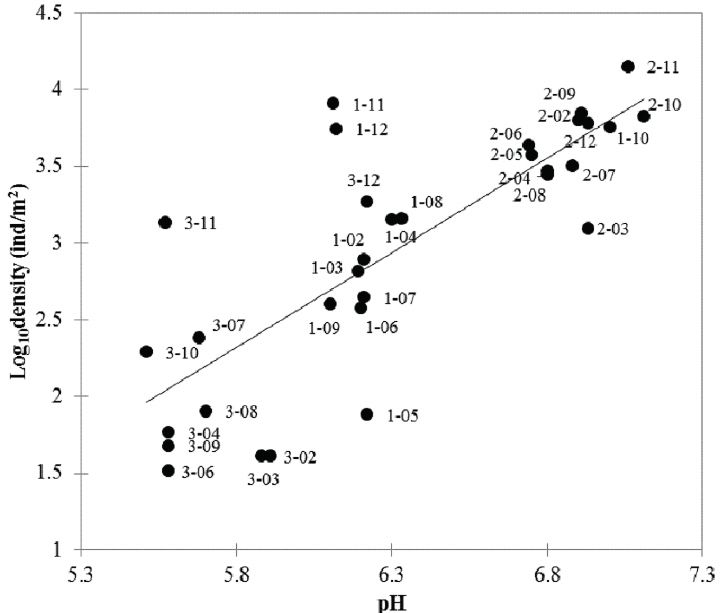
amphipod density. 10